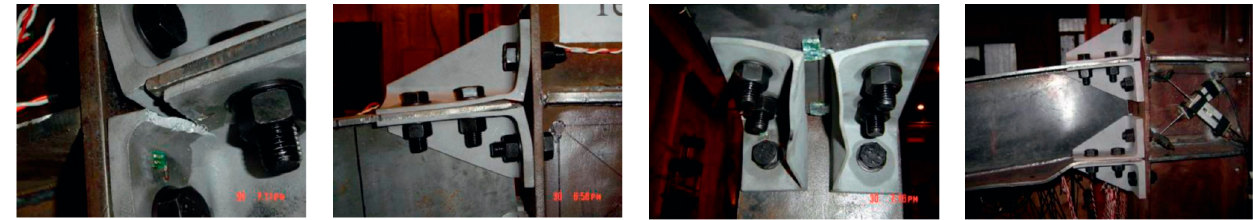
Figure 17. Replaceable cast steel connectors [230] reproduced under the Creative Commons